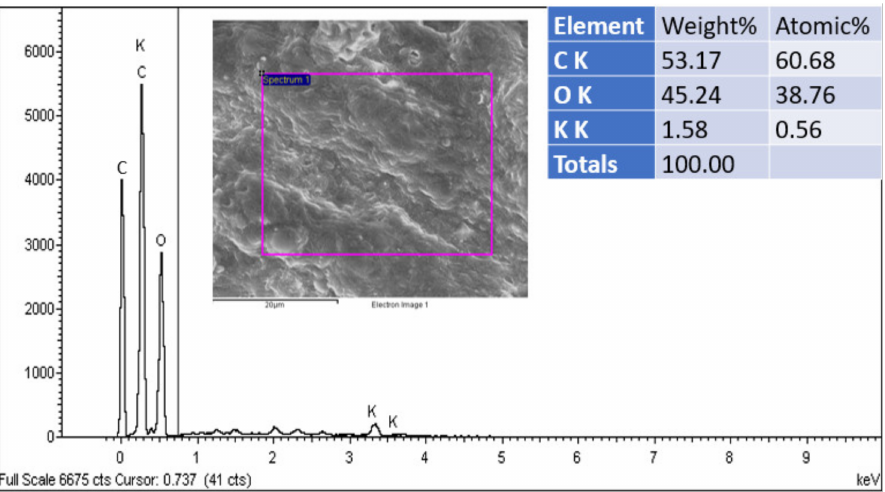
Figure 7. EDX spectra of the treated anode after completion of BMFC